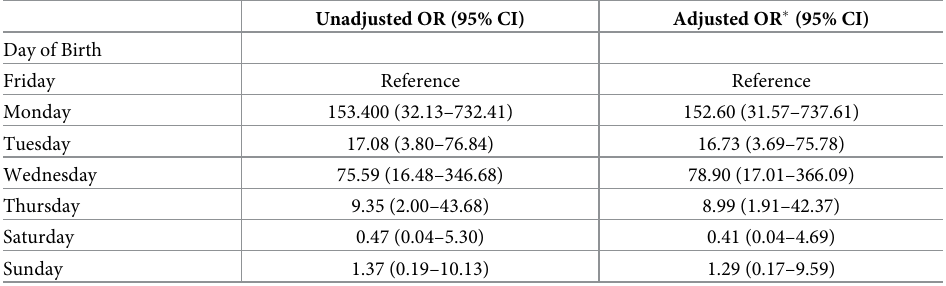
Table 2. Multivariable analysis of the association between day of birth and the odds of receiving a timely birth dose of HBV